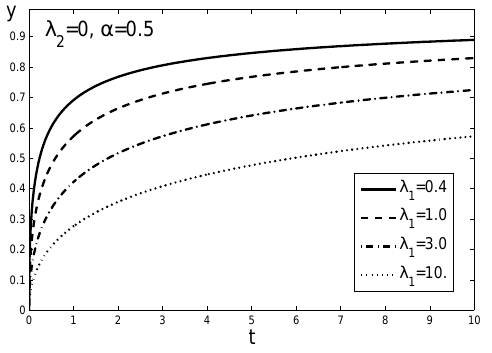
Fig. 2. Time profile of the pressure gradient for A = 1 , λ 2 = 0 , α = 0 . 5 and various values of λ 1 .